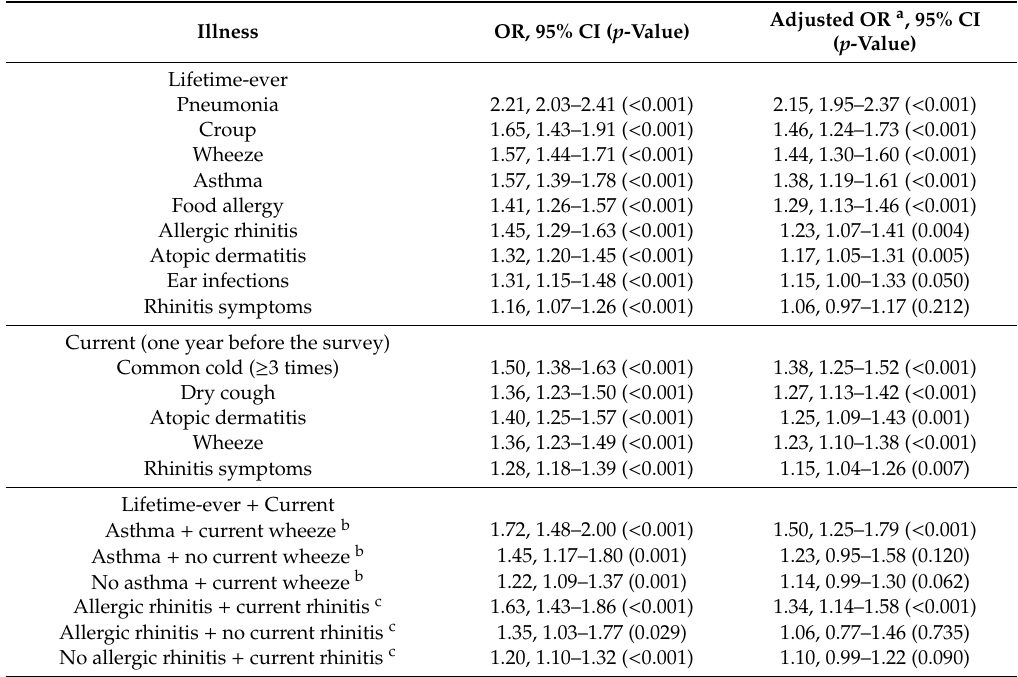
Table 3. Associations between first-year antibiotics exposure and childhood asthma, allergies, and airway